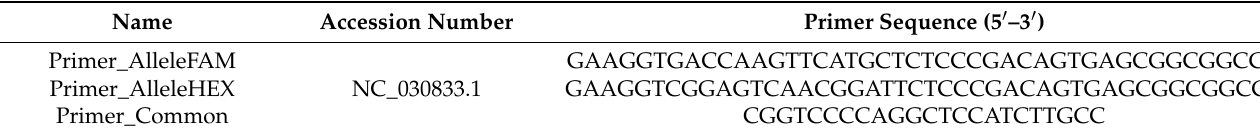
Table 2. Primers and probes for SNP-KASP.